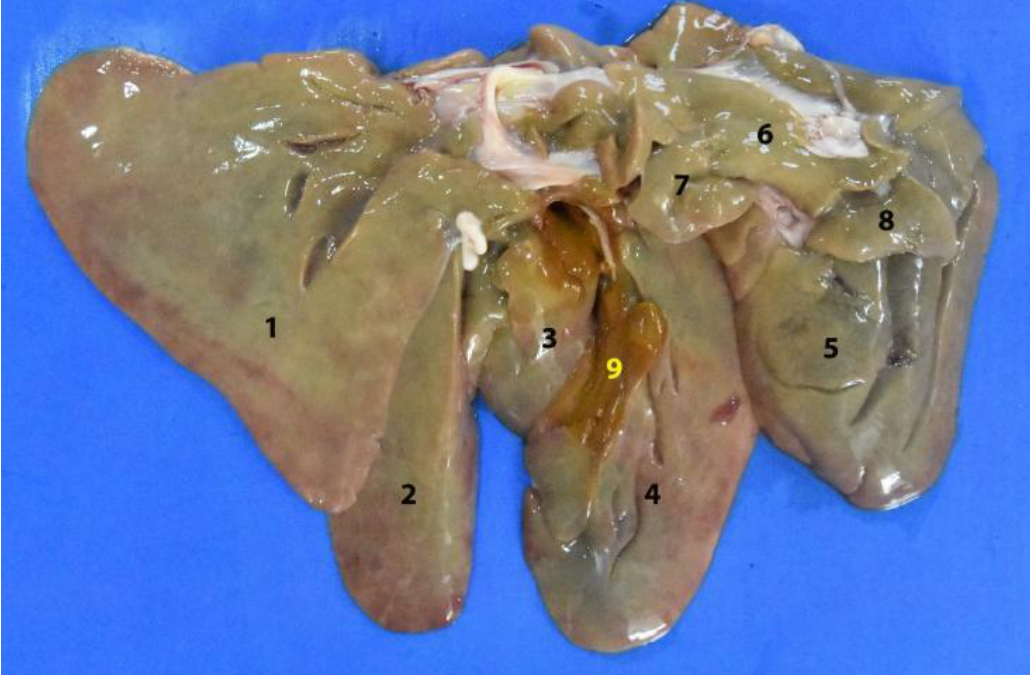
Figure 25. Visceral face of the liver. ( 1 ) Left lateral lobe; ( 2 ) left medial lobe; ( 3 ) quadrate lobe; ( 4 ) right medial lobe; ( 5 ) right lateral lobe; ( 6 ) caudate lobe; ( 7 ) papillary process; ( 8 ) caudate process; ( 9 ) gallbladder fossa.